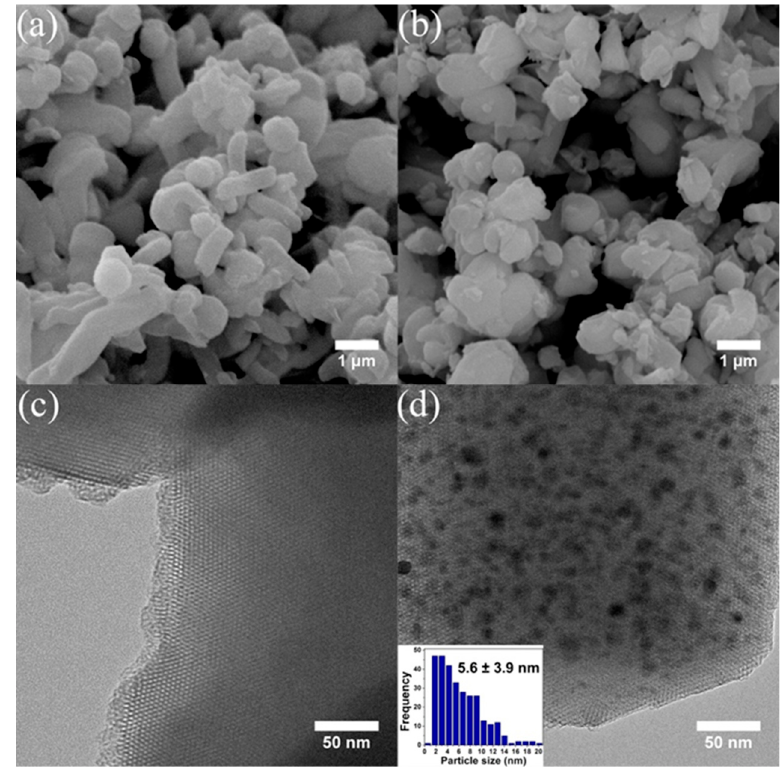
Figure 3. SEM images of MCM-41 ( a ) and M-10Ni3P ( b ); TEM images of MCM-41 ( c ) and M-10Ni3P ( d ).